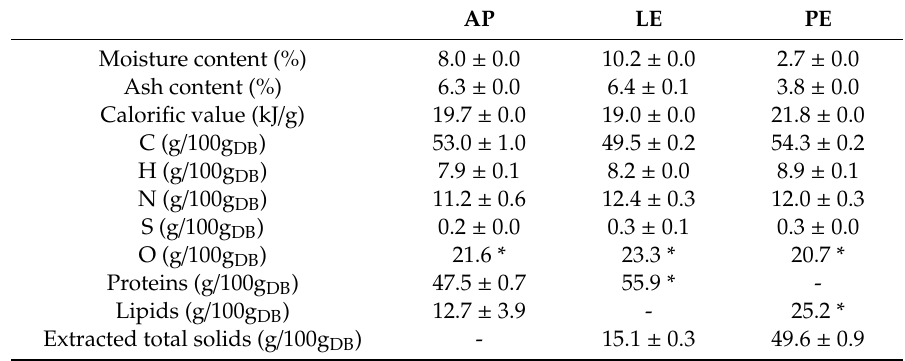
Table 1. Quantification of components of Arthrospira platensis biomass before extractions (AP), after extraction of lipids (LE), and after extraction of proteins (PE)